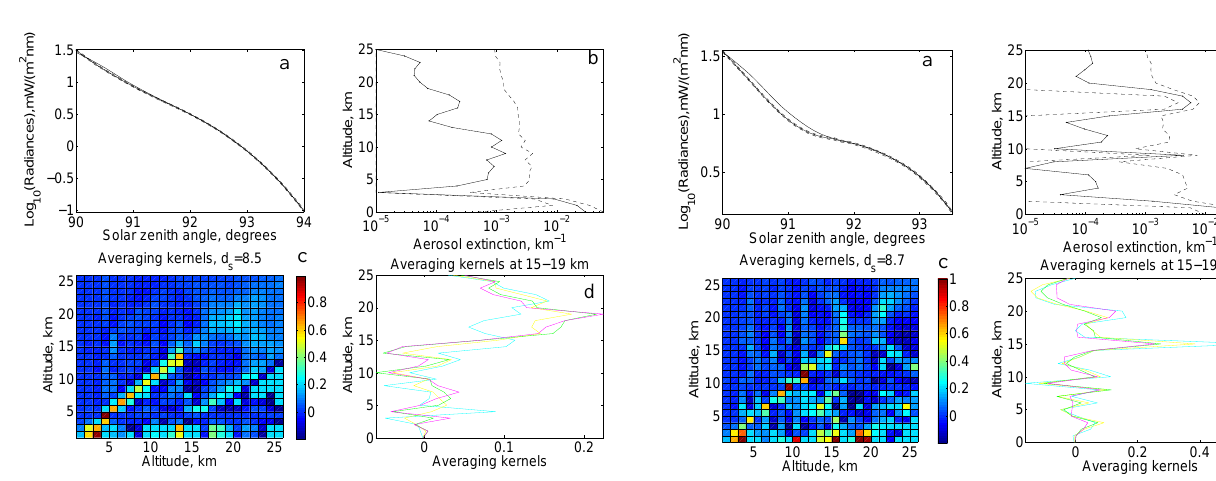
Fig. 10. Date of observation: 29 July 2011. Idem as